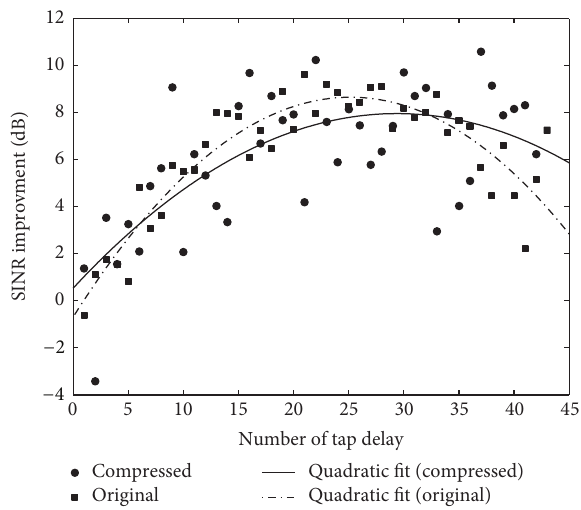
Figure 4: SINR improvement as a function of number of delay taps.